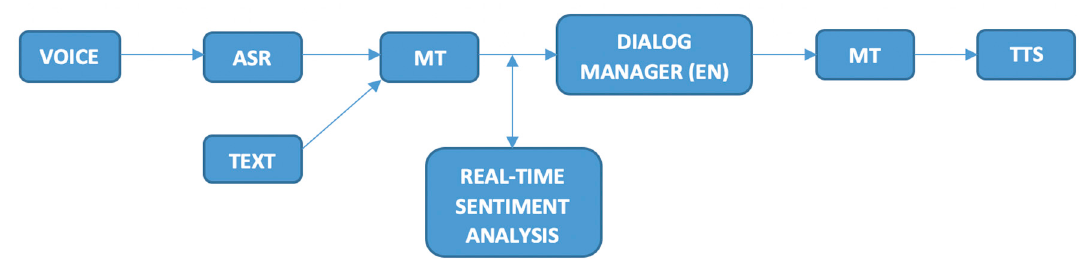
Figure 1. Diagram of the dialog system with the analysis of the dialog sentiment.